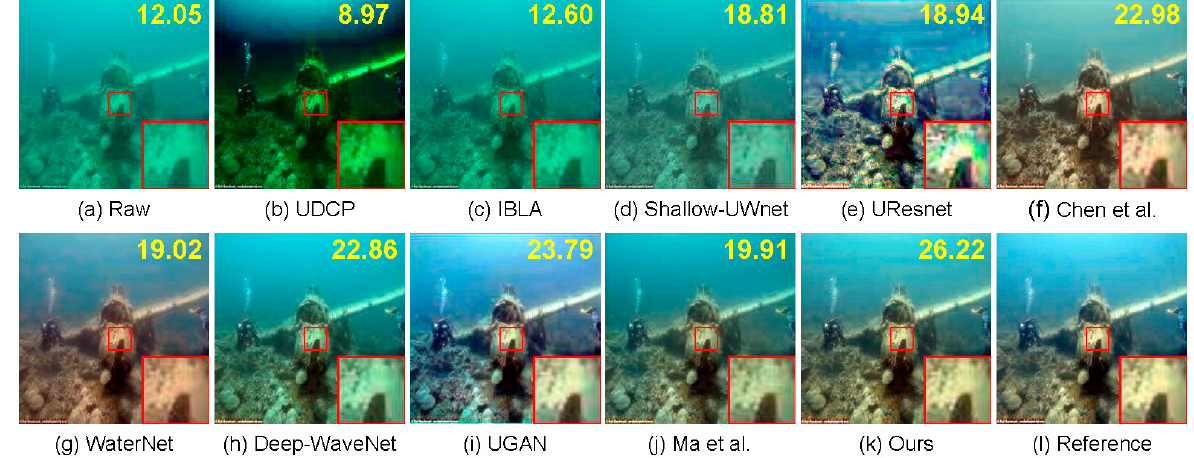
Remote Sens. 2023 , 15 , x FOR PEER REVIEW Figure 8. The visual comparisons of various UIE approaches on greenish underwater images. The number on each image represents its PSNR score.